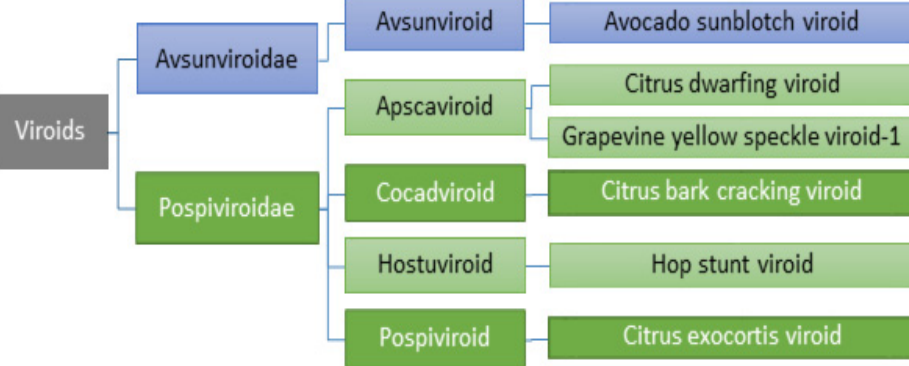
Figure 2. ICTV taxonomy of viroids tested in SE experiments.